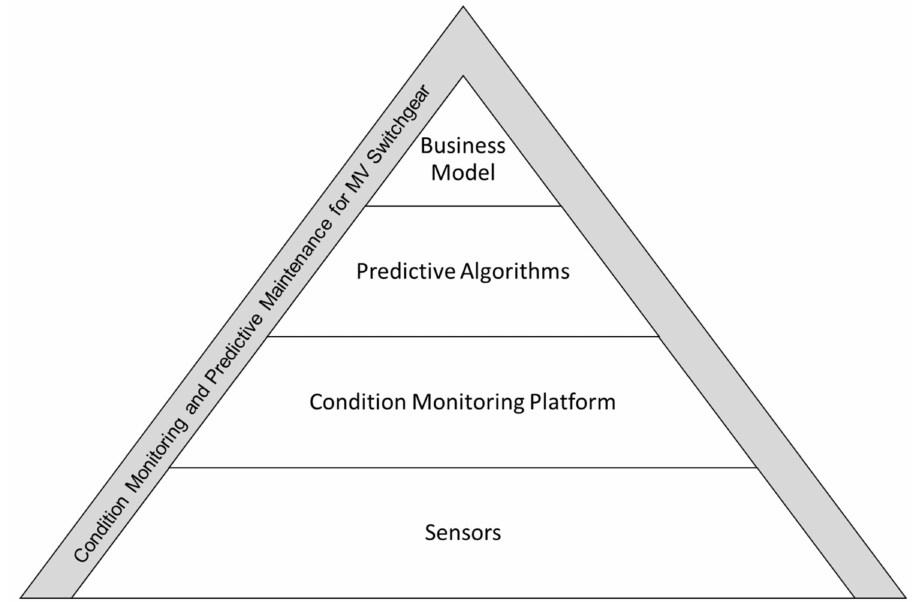
Figure 3. A comprehensive view of condition monitoring and predictive maintenance of medium voltage